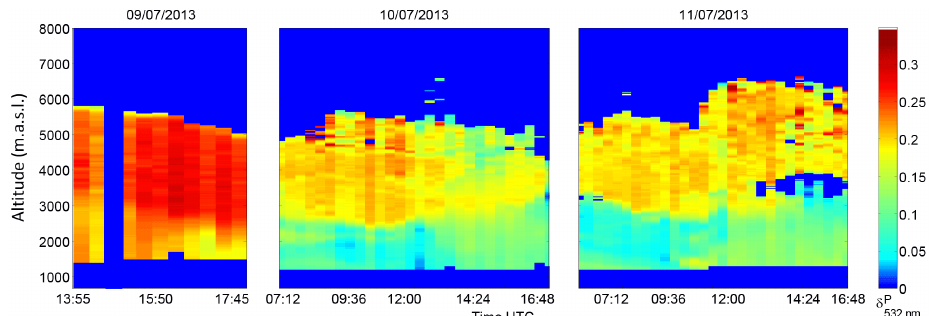
Figure 8. Time series of the δ p profiles retrieved from the Granada lidar system at different time intervals during the ChArMEx July 2012 532nm intensive measurement period. The dark blue color represents regions and time periods where no data were retrieved.